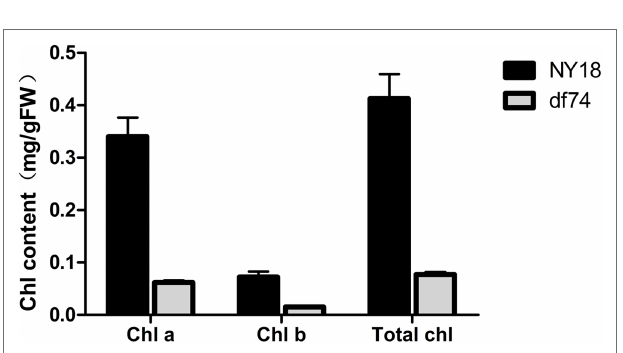
FIGURE 2 | Chlorophyll (Chl) contents in sepals of NY18 and